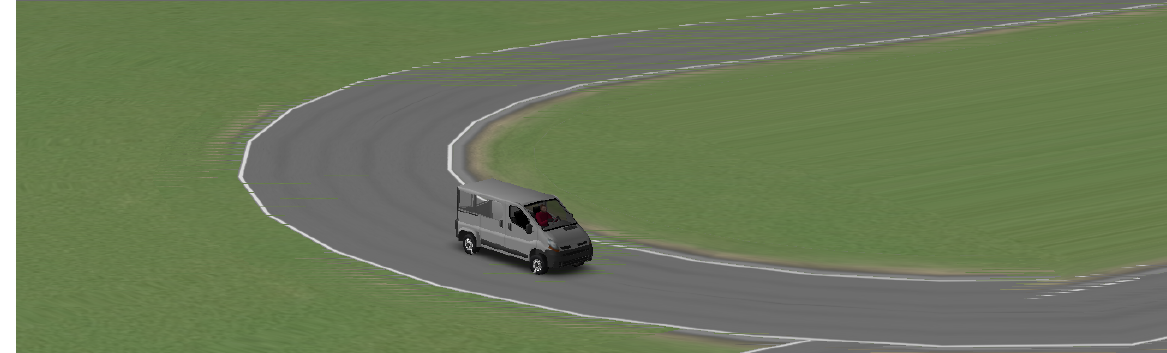
Figure 8. Test 1 and Test 3: Roundabout with a radius of 22 m.